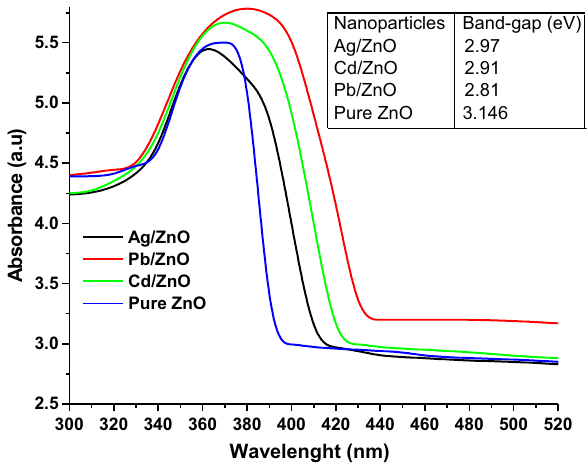
Fig. 1 Absorption edges and band-gap energies of modified ZnO nan- oparticles in the UV–Vis